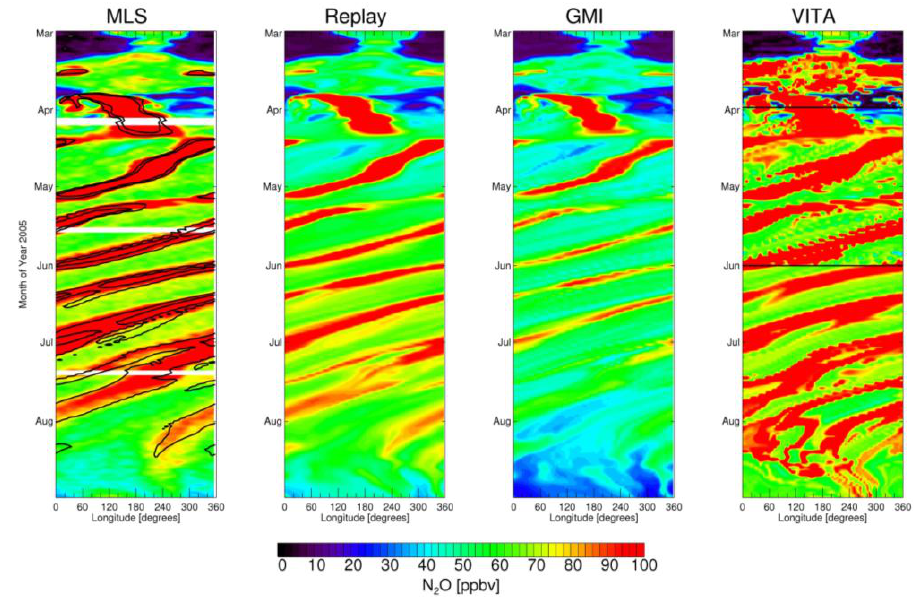
Fig. 16. Longitude vs. time Hovm¨oller plots of N 2 O at 850K, 78 ◦ N for MLS, Replay, GMI, and VITA from March to September 2005. Red (blue) indicates high (low) N 2 O values. The black contours on the MLS plot are the 75 and 100ppbv contours of the Replay simulation, for direct comparison with MLS. White regions on the MLS plot indicate no data available during that time period. The VITA contours are produced from a composite of three runs of the model, initialized with MLS N 2 O on 1 March, 1 April, and 1 June, as indicated by the horizontal black lines.